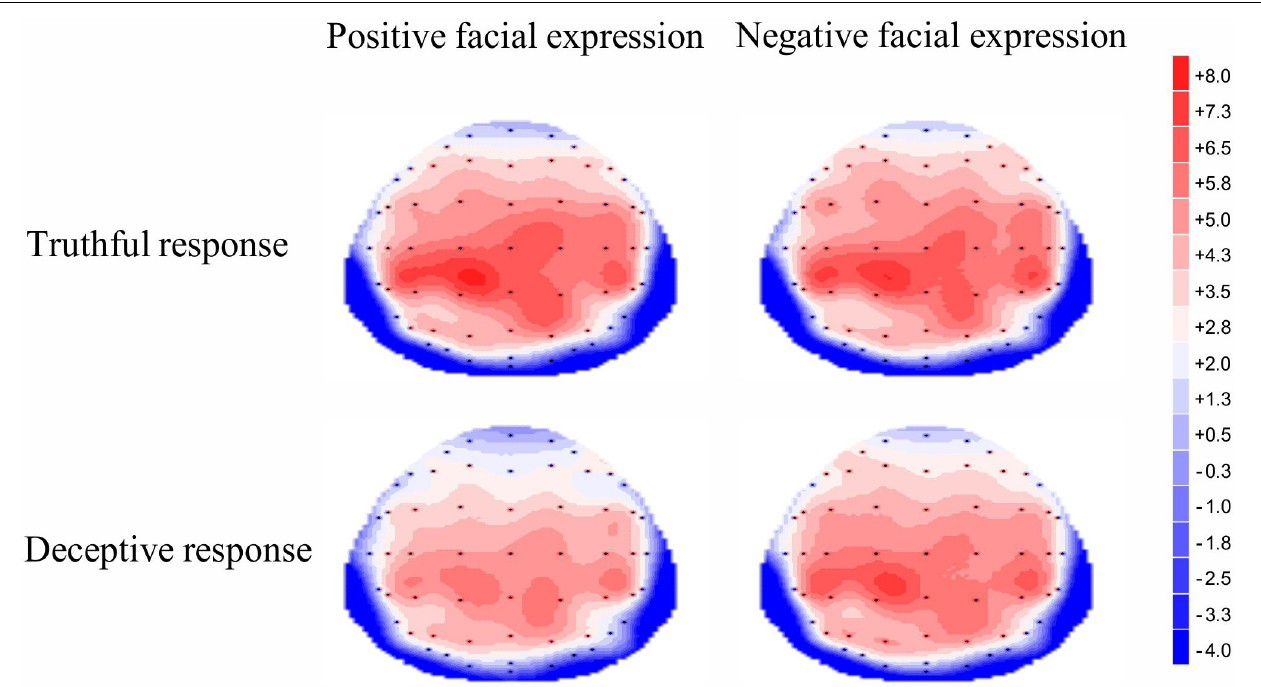
FIGURE 6 | Topographic maps of the mean voltage amplitudes for the four experimental conditions in the 450–750 ms time